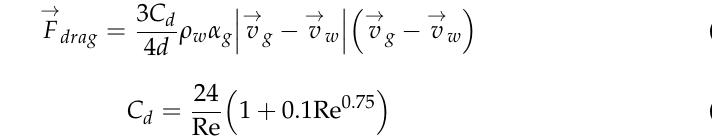
Figure 10. Magnitude of velocity fluctuation under different initial bubble velocity.